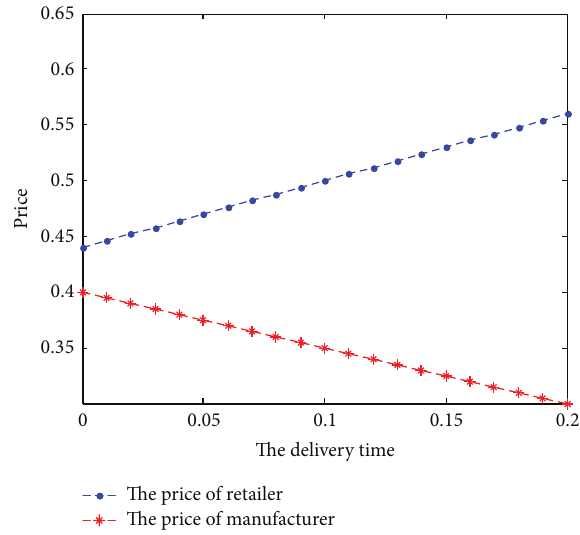
Figure 2: Effect of the delivery time on Stackelberg equilibrium